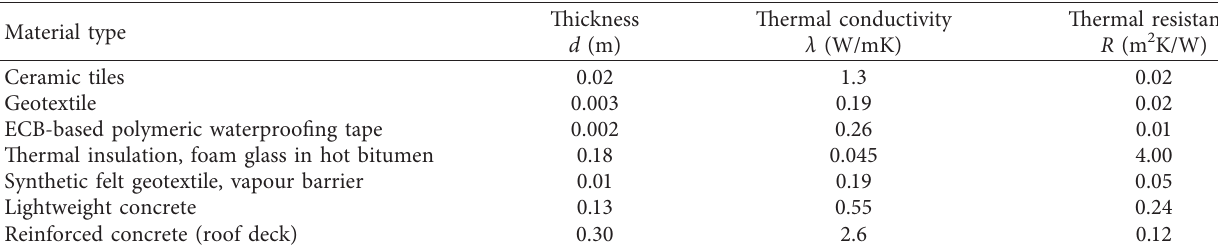
Figure 4: Intensive green roof Gantt chart (the figure is created by authors upon data collected from cost estimate for the building under Table 2: Thermal resistance of layers of a conventional flat roof (the table is structured by authors upon data collected from cost estimate for the building under construction).